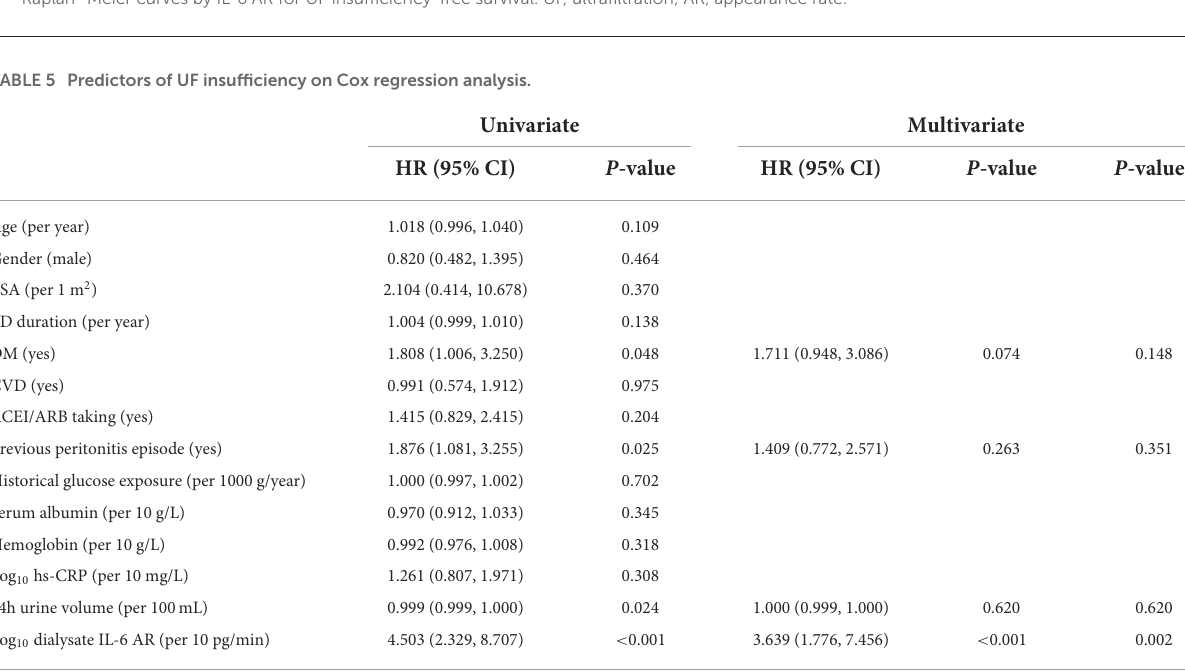
FIGURE4 Kaplan–Meier curves by IL-6 AR for UF insufficiency-free survival. UF, ultrafiltration; AR, appearance rate.